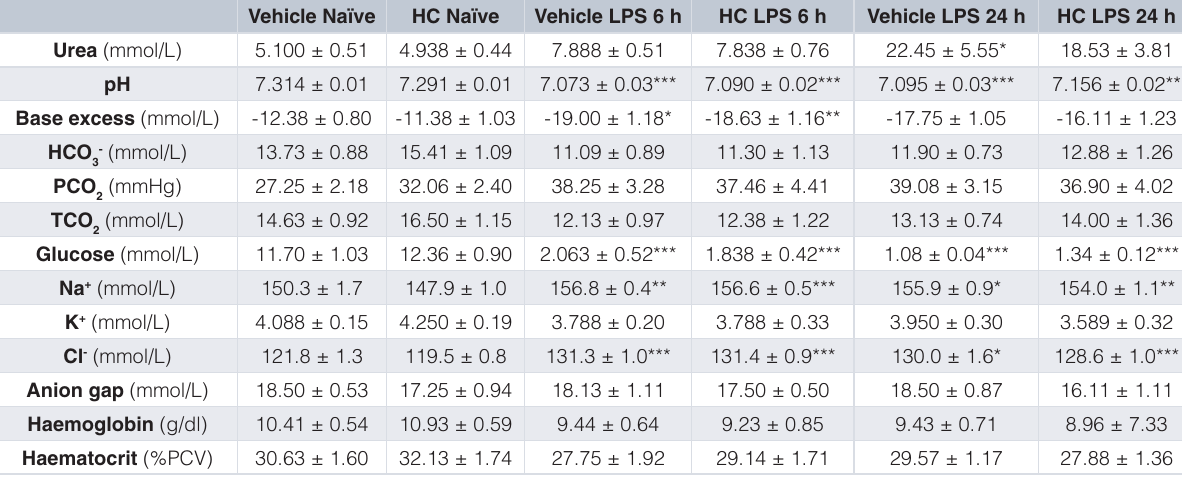
Table 3. Blood biochemistry in healthy and endotoxaemic WT mice treated with TRPV4 antagonist or vehicle. Blood gas and biochemistry were measured from venous blood samples by iSTAT point-of-care analyser in WT mice treated i.p. with vehicle (10% DMSO) or HC-067047 (HC), either under naïve (24-h treatment) or endotoxaemic (LPS 12.5 mg/kg, i.v., 6 h or 24 h) conditions. Data are presented as mean ± SEM. *p<0.05, **p<0.01, ***p<0.001, relative to naïve controls, 1-way ANOVA + Bonferroni post-hoc test (n = 8–9).